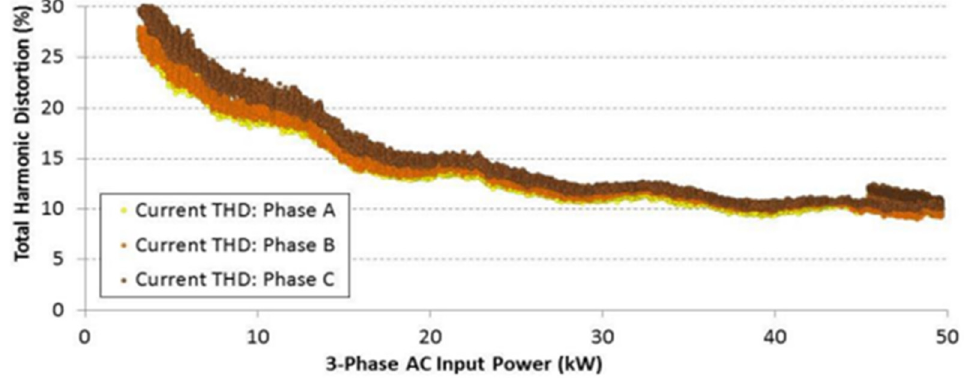
Figure 12. Total harmonic distortion (THD) for phase a, b, and c of 50 kW ABB DCFC. (Reprinted with permission from Ref. [152]. Copyright 2016 INL.)